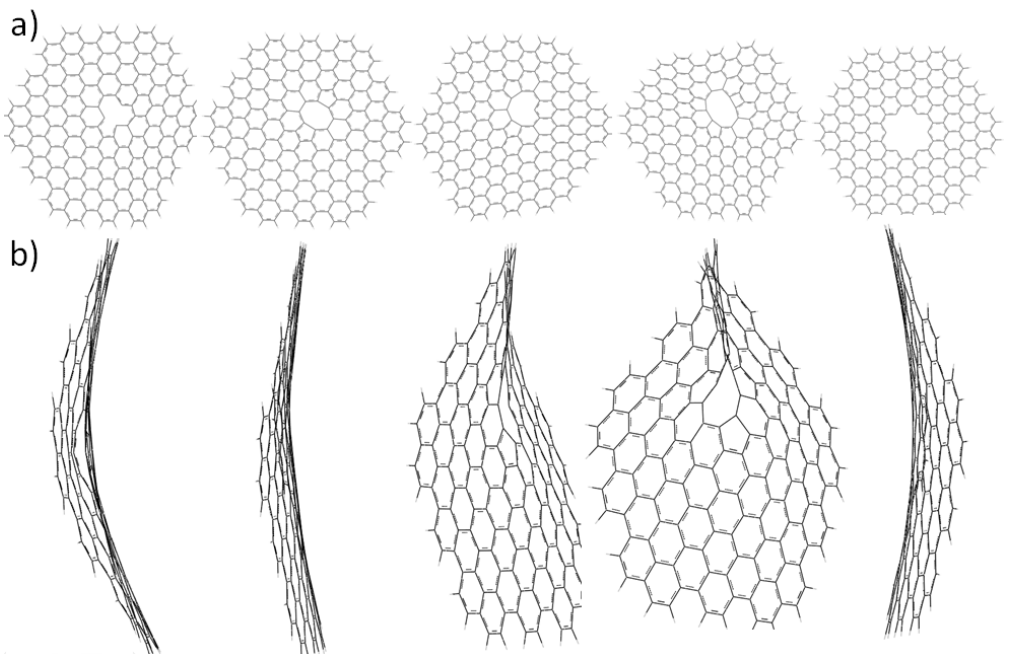
Figure 6. 6-A-HGNS containing vacancy defects change their optimized structures from planar to saddle-like: (i) mono- vacancy; (ii) di-vacancy; (iii) tri-vacancy; (iv) tetra-vacancy; and (v) hexa-vacancy; ( a ) elevation view and ( b ) side